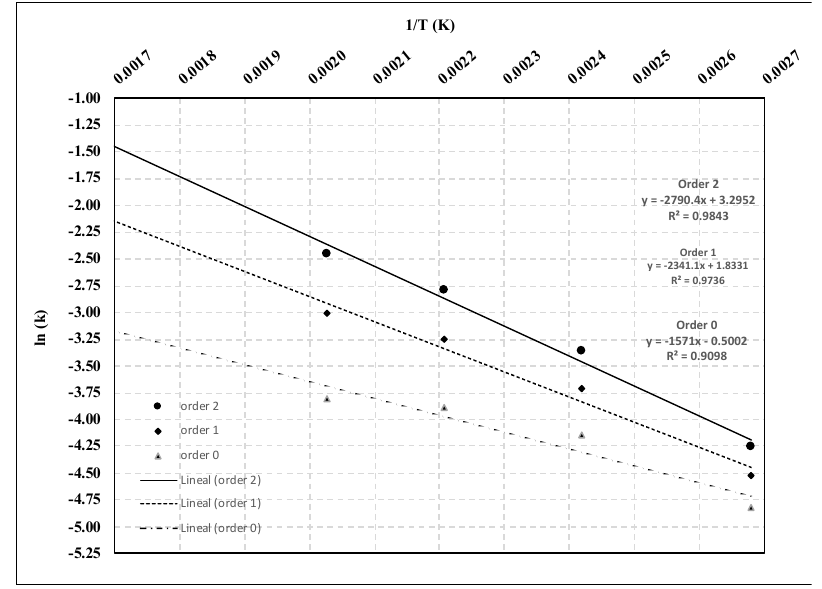
Figure 2. Effect of temperature on the kinetic constants during the roasting process to n order. Figure 2. E ff ect of temperature on the kinetic constants during the roasting process to n